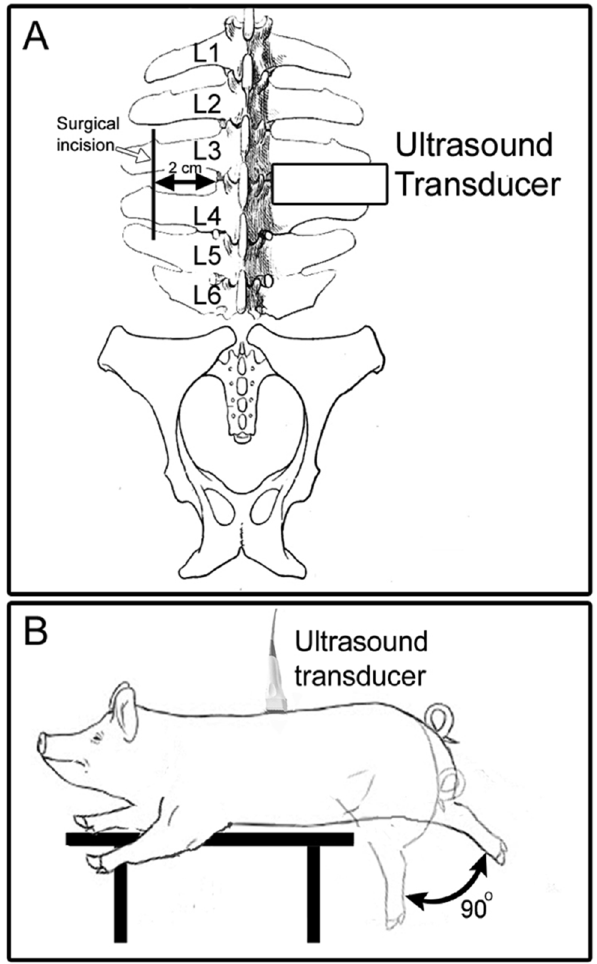
Fig 2. Ultrasound data acquisition methods. (A) Location of ultrasound images used for determination of fascia thickness. (B) Method used for acquisition of ultrasound cine-recording during passive trunk